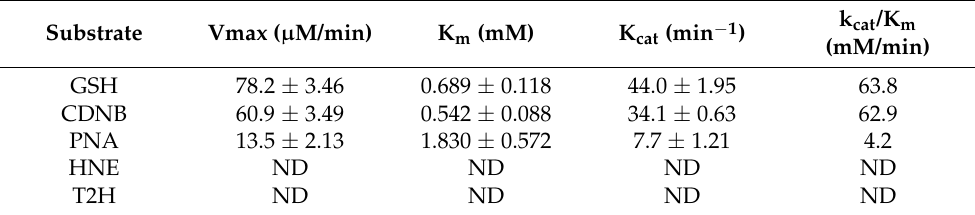
Table 2. Kinetic parameters for the conjugation of GSH with CDNB and PNA. GSH: glutathione, CDNB: 1-chloro-2,4-dinitrobenzene, PNA: p-nitrophenyl acetate, HNE: 4-hydroxynonenal, T2H: trans-2-hexen-1-al, ND: no enzyme activity